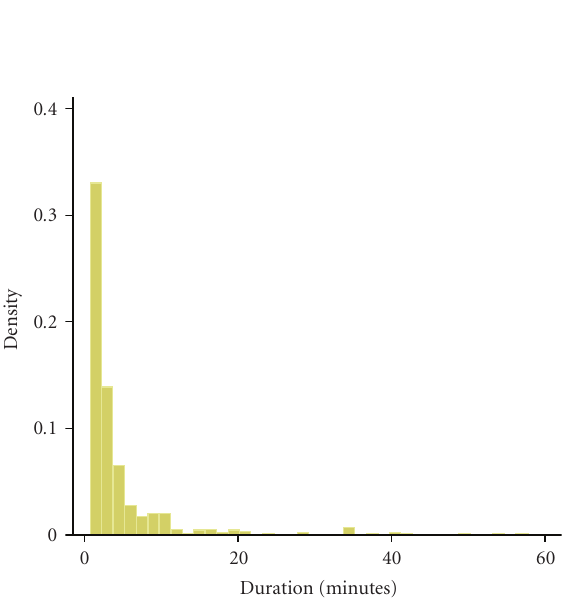
Figure 5: Congestion duration